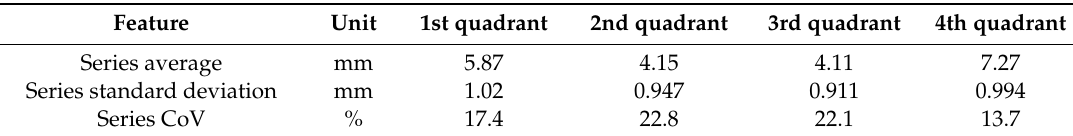
Figure 11. Max penetration distribution of streamers in the four quadrants. The white cross in the middle is the igniter center. The discharge in the background is only for the sake of comprehensibility. Table 5. P max statistic results: series average, series standard deviation, and series coe ffi cient of variation for the four quadrants.